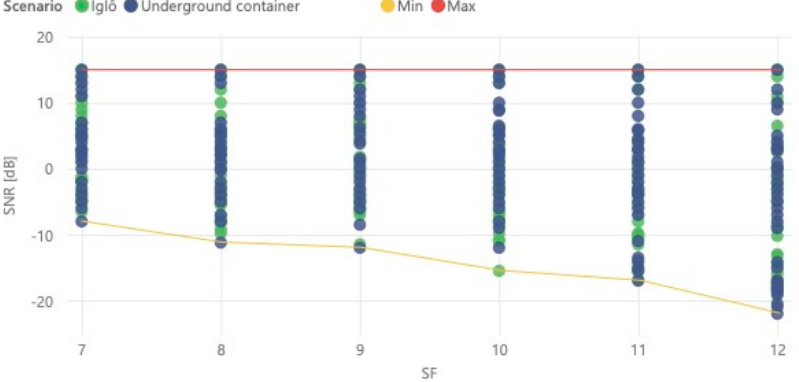
Figure 15. Received message SNR versus spreading factor.